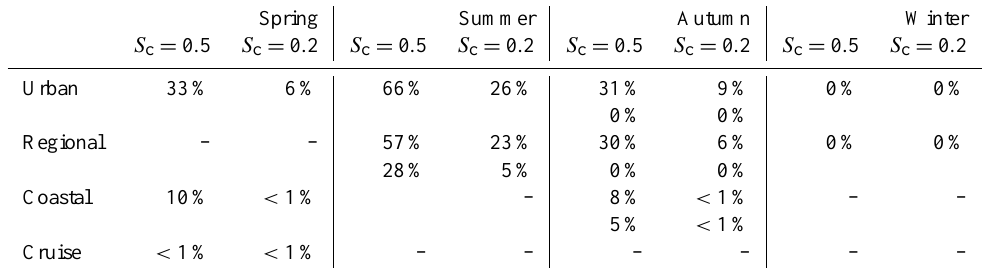
Table 4. Summary of contribution of NPF events to potential CCN during the time between 14:00 to 17:00LT in all measurements. Spring Summer Autumn Winter S c = 0 . 5 S c = 0 . 2 S c = 0 . 5 S c = 0 . 2 Urban 33% 6% 66% 26% 31% 9% 0% 0% Regional – – 57% Coastal 10% < 1% – < 1% – – 5% < 1% Cruise < 1% < 1% – – – – –